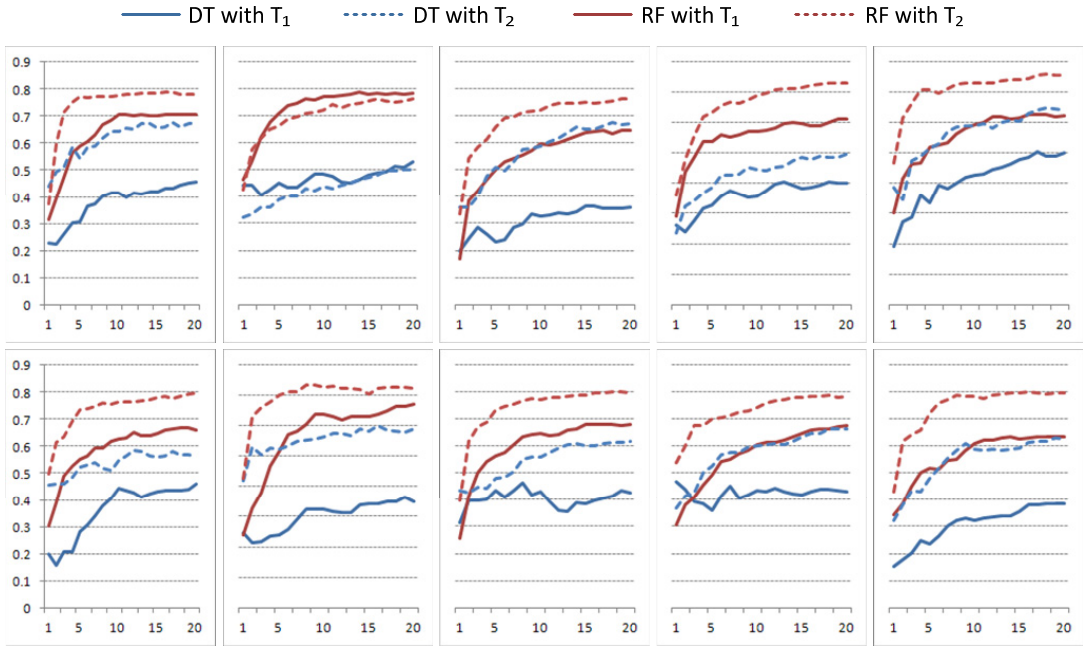
Figure 12. Classification improvements of the 10 instances of training sets T 20 iterations of self-training for the two base learners Decision Tree (DT) and Random Forest